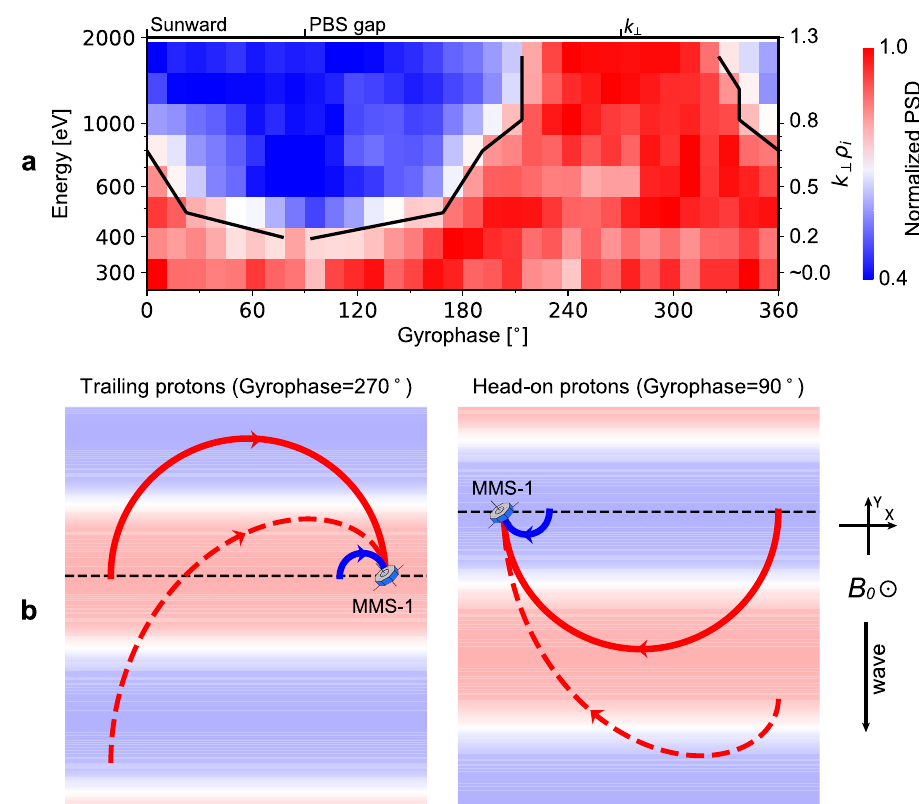
Fig. 4 | KAW-proton interactions. a The extent of phase-bunching stripe gaps (marked by the blue colors), which systematically increases as proton perpendi- cularenergy and thus k ? ρ i increase. The black curve marks the 0.8 level.From left to right, The three labels on the top give the gyrophases of the sunward direction, PBS gaps and the propagation direction of the KAWs in the perpendicular plane. b Diagrams illustrating the geometryof KAW propagation and protontrajectory in the plane perpendicular to B 0 . The red-blue background illustrates wave phases.